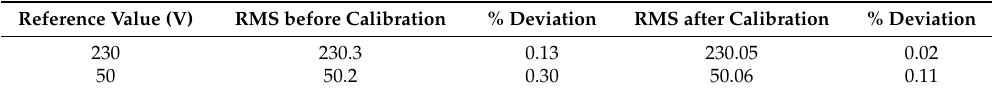
Table 1. Voltage Calibration Results.